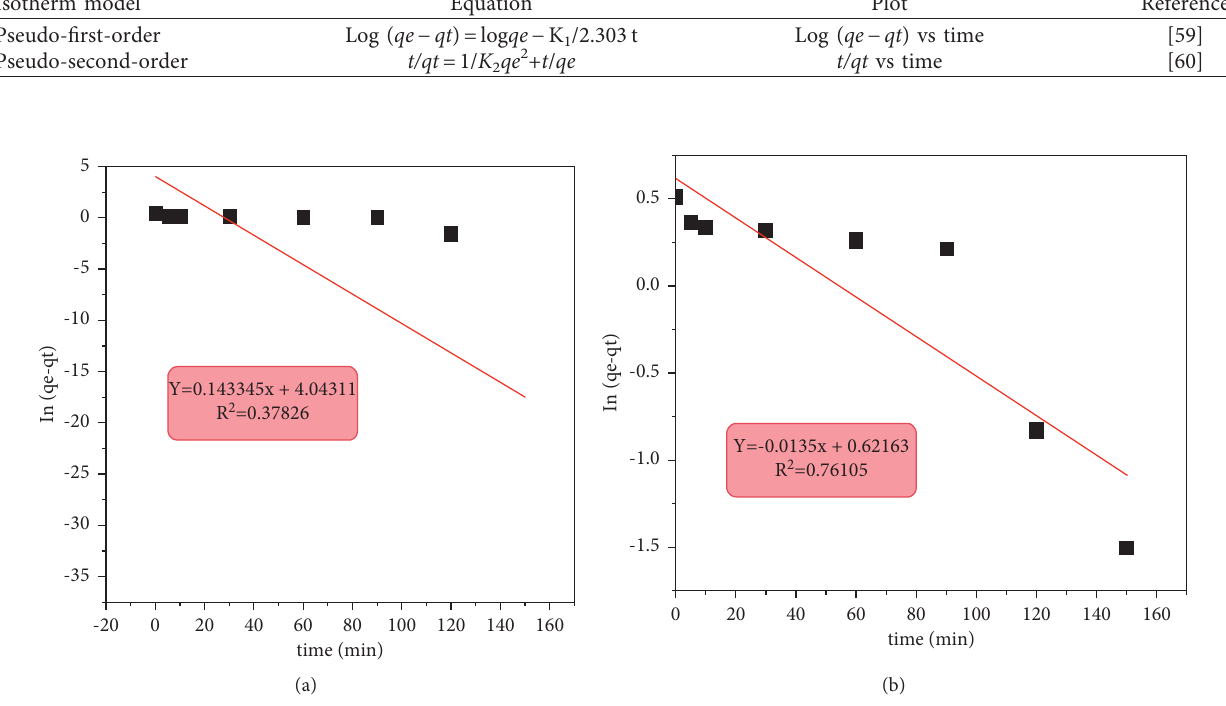
Figure 11: Pseudo-first-order model for (a) Z-A and (b) Z-B samples.